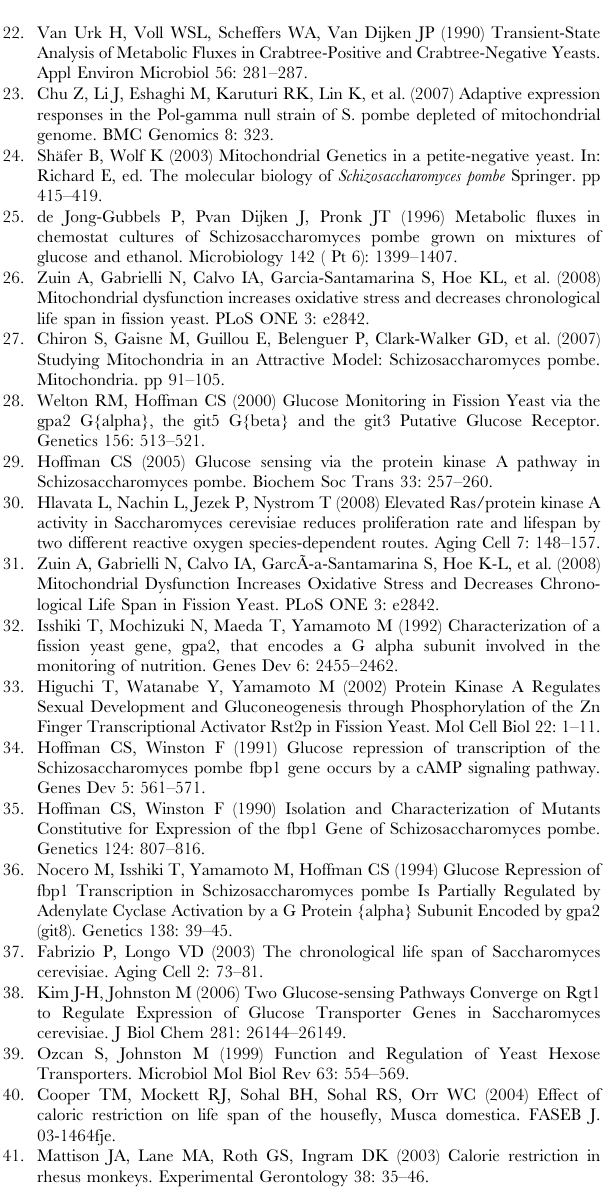
Figure S5 Chronological life span of WT and D git3 grown in 2% and 0.2% glucose with 20 m g.mL 2 1 antimycine A (AA). Vector corresponds to ethanol to a final concentration to 0.1%. Figure S6 b -Galactosidase activity of D git3 and gpa2 R176H with fbp1-lacZ reporter both grown in 2% and 0.2% glucose. Cells were collected at late exponential phase and b -Galactosidase activity was measured.